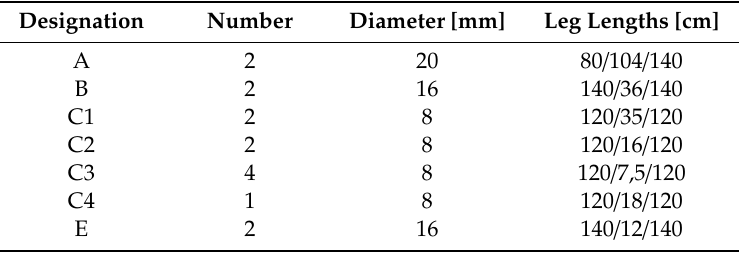
Table 1. Reinforcement in the end zone of the instrumented girder.